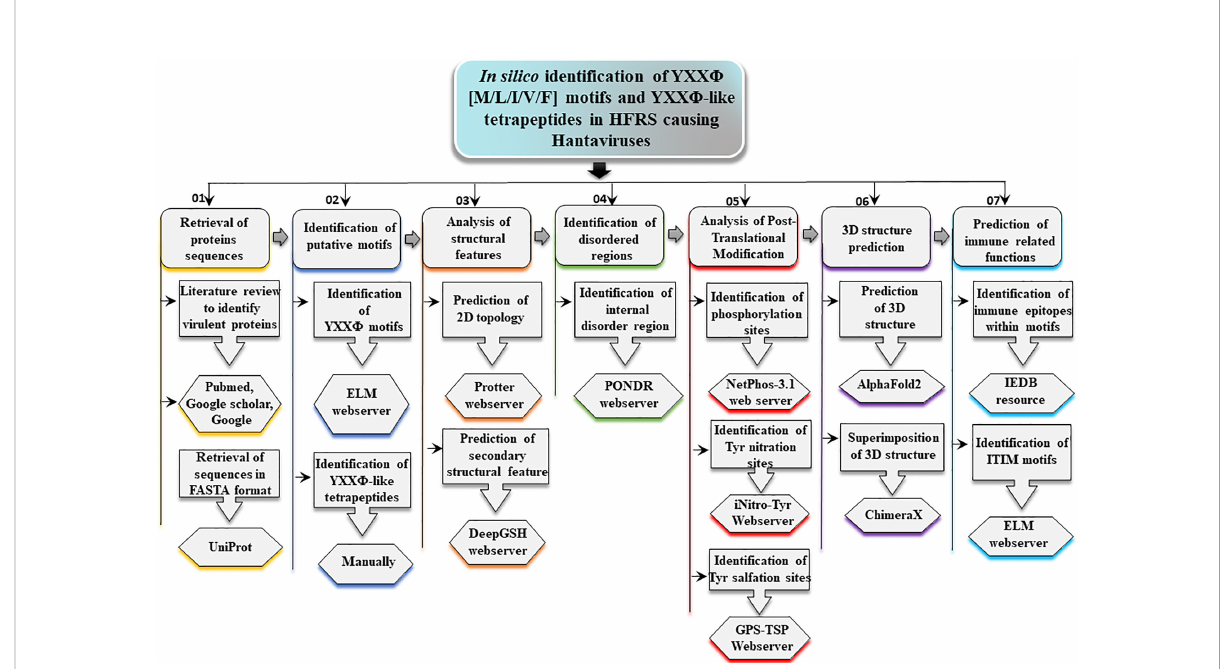
FIGURE 1 Graphical representation of methodology adopted to uncover YXX F [I/L/M/F/V] motifs and YXX F -like tetrapeptides within nucleoprotein sequences of PUUV, SEOV, DOBV, and